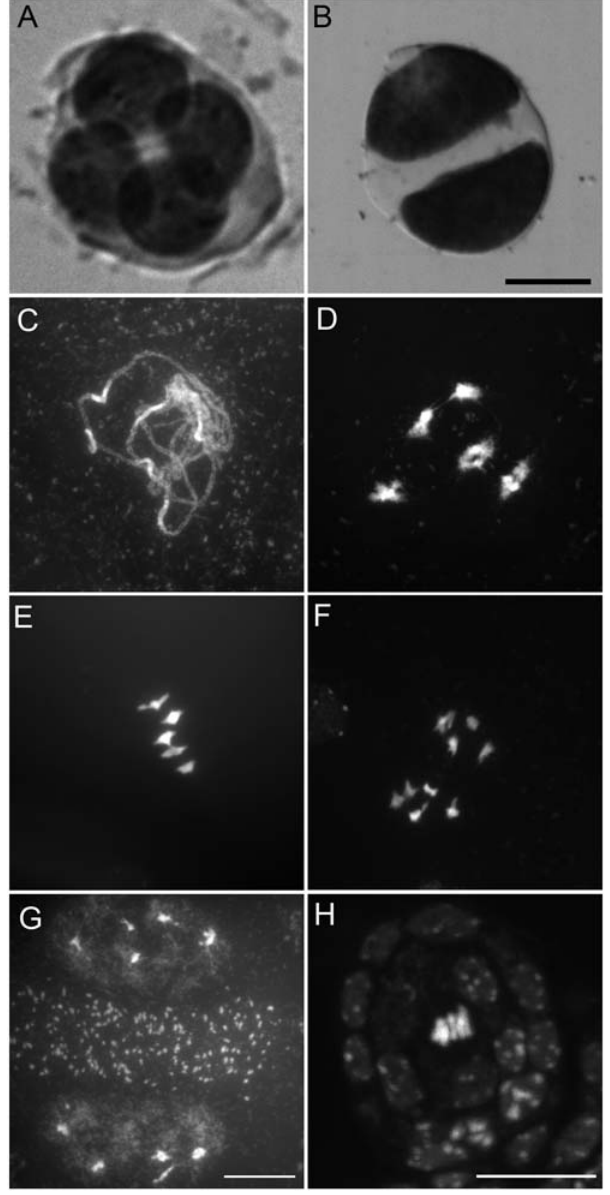
Figure 3. osd1 mutants skip meiosis II. (A and B) Male meiotic products stained with toluidine blue. (A) A wild-type tetrad. (B) A dyad in the osd1-1 mutant. (C–D) Male meiosis in osd1 is indistinguishable from wild type until telophase I (compare to figure 4), but no figures characteristic of a second division were observed. (C) Pachytene. (D) Diakinesis. (E) Metaphase I. (F) Anaphase I. (G) Telophase I. Two nuclei separated by a band of mitochondria are observed. (H) Metaphase I of female meiosis in osd1